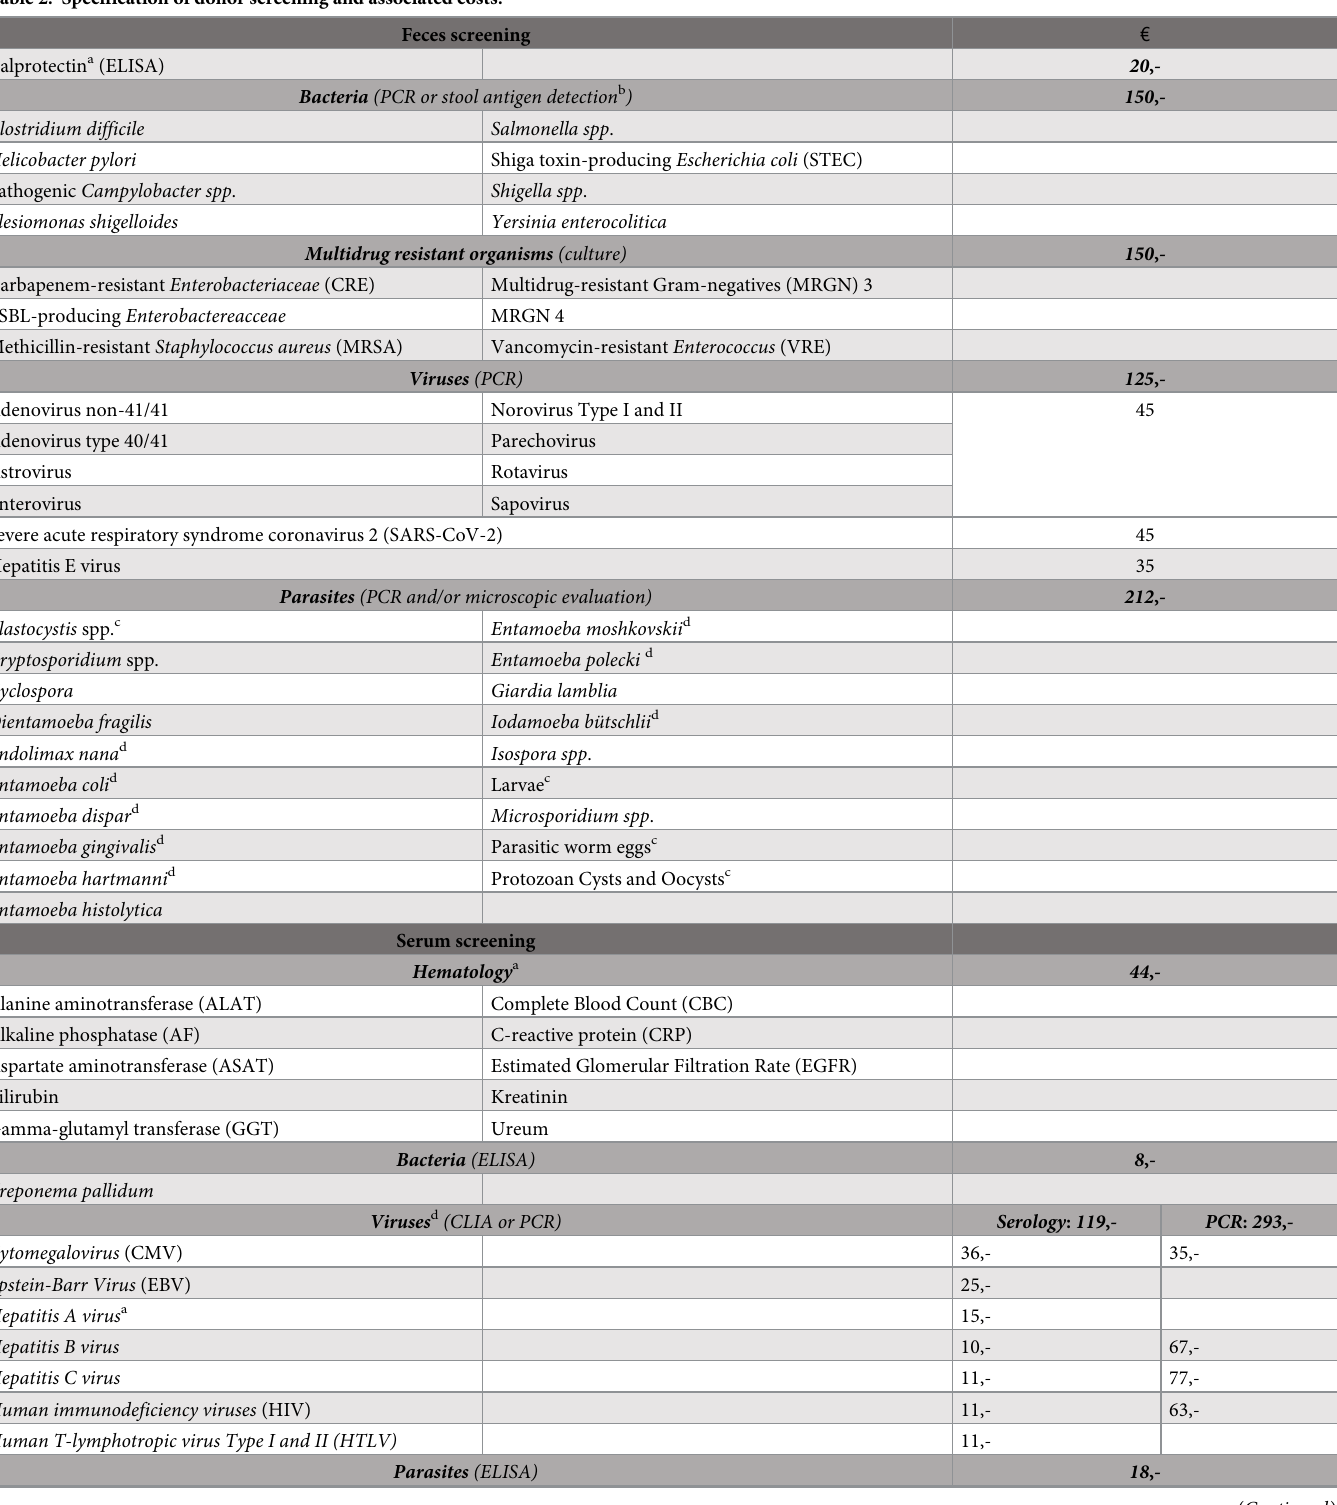
Table 2. Specification of donor screening and associated